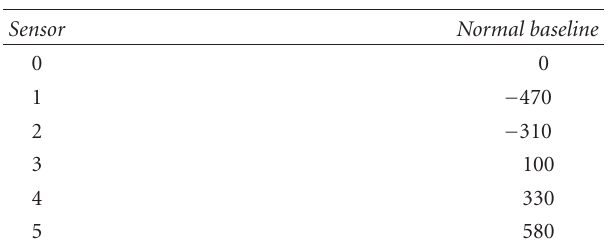
Table 1: Baselines table.